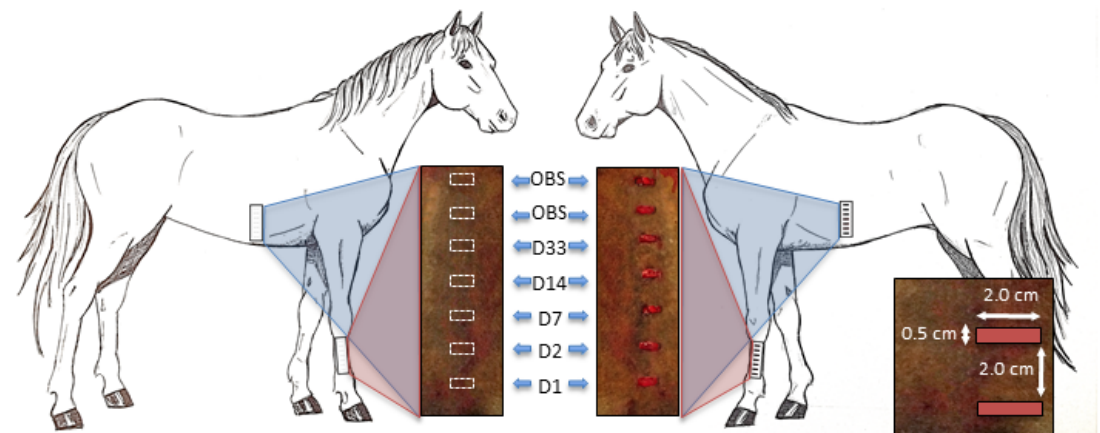
Figure 1. Basic schematic of wound creation and sequence of biopsy collection. On day 0, seven wounds were created on the left forelimb and hemi-thorax of each horse measuring 0.5 cm × 2.0 cm and placed 2 cm apart in a vertical orientation. Biopsies were collected on days (D) 1, 2, 7, 14, and 33 from the wound site and from the corresponding contralateral non-wounded site in a distal to proximal sequence. The top two wounds were left to heal by second intention and observed for healing characteristics. (OBS), observed.